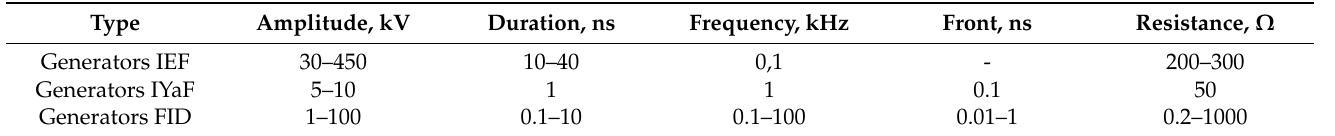
Table 1. Characteristics of generators.